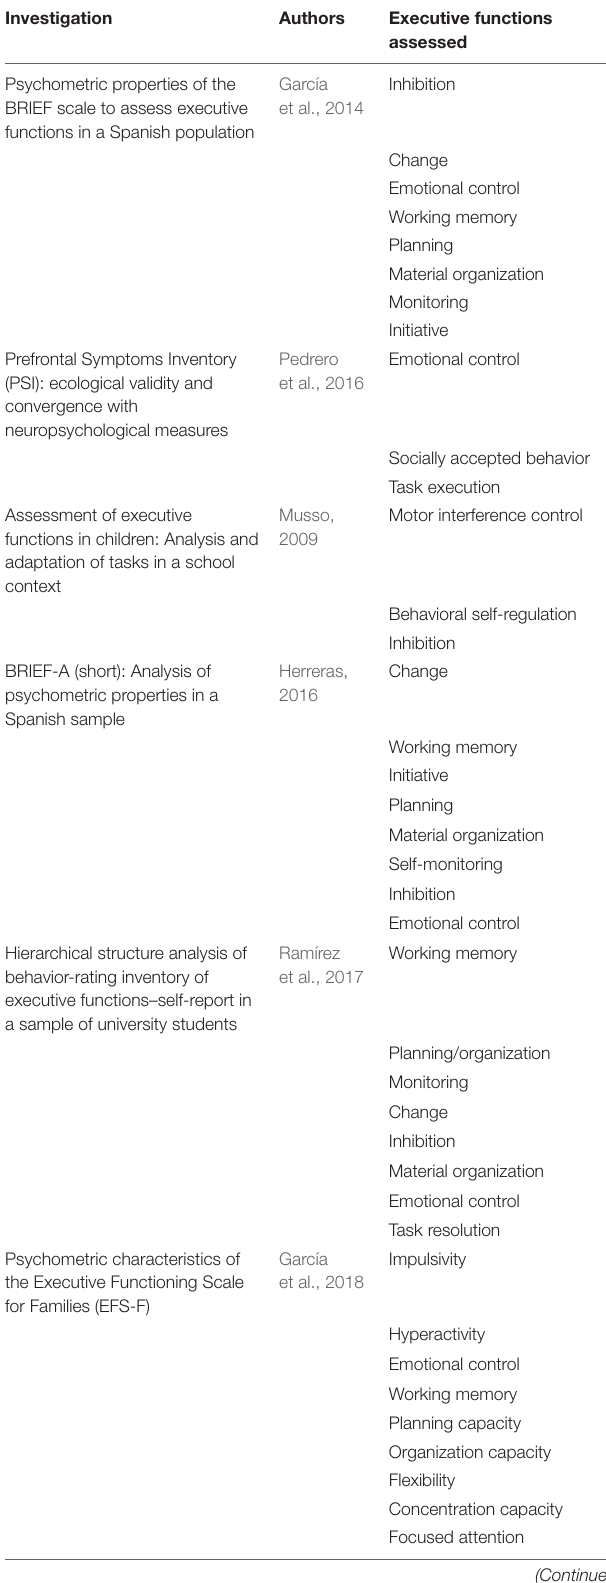
TABLE 1 | Revision of the scales to assess executive